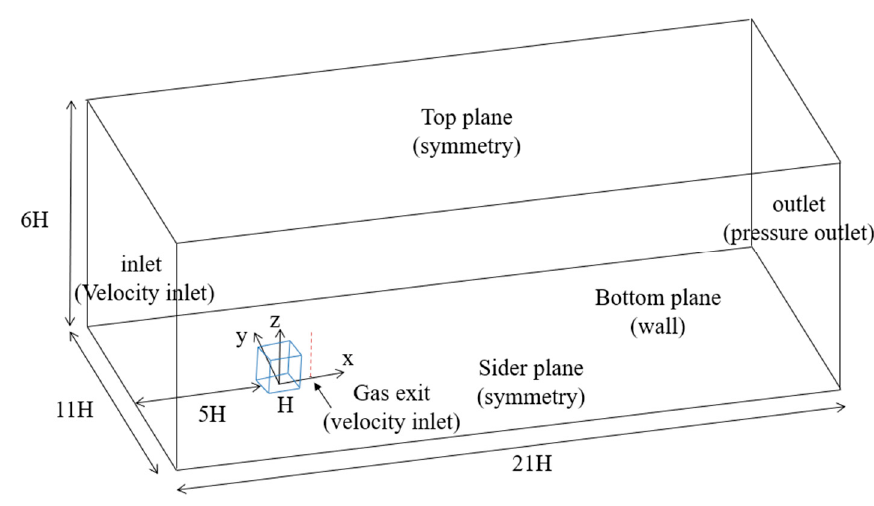
Figure 2. Computational domain and boundary conditions of the single building case.